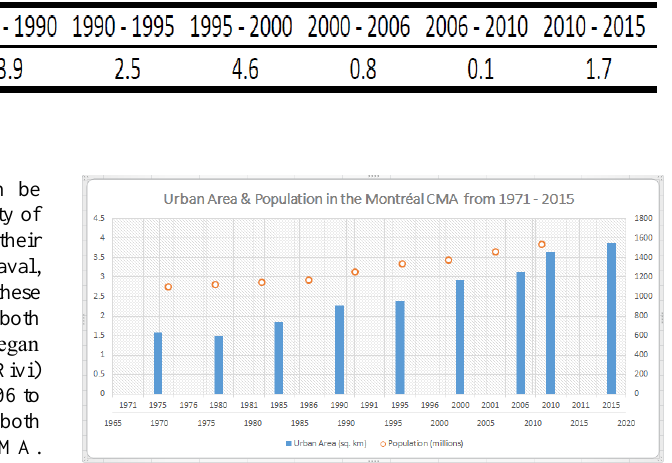
Fig. 4. Urban area and population statistics in the Montréal CMA